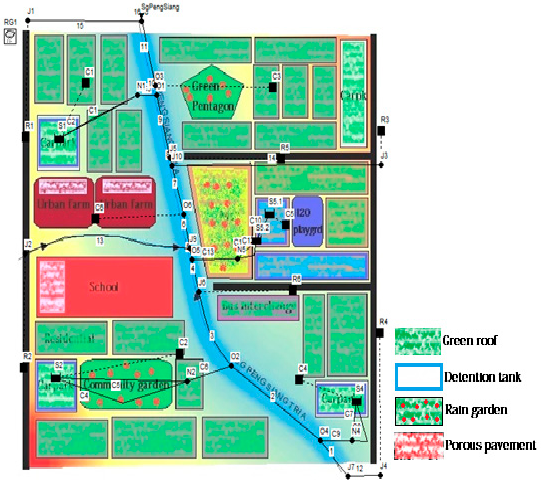
Figure 7. SWMM set up of Tengah Subcatchment (TSC) with ABC Waters design features incorporated.